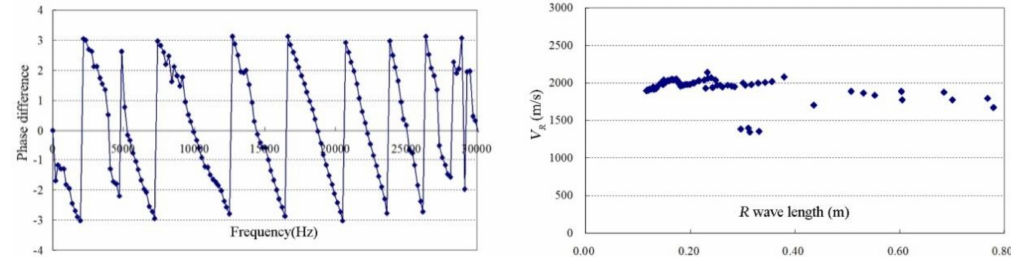
Figure 14. Phase spectrum and dispersion curve of the layered model 3 @ impact duration 100